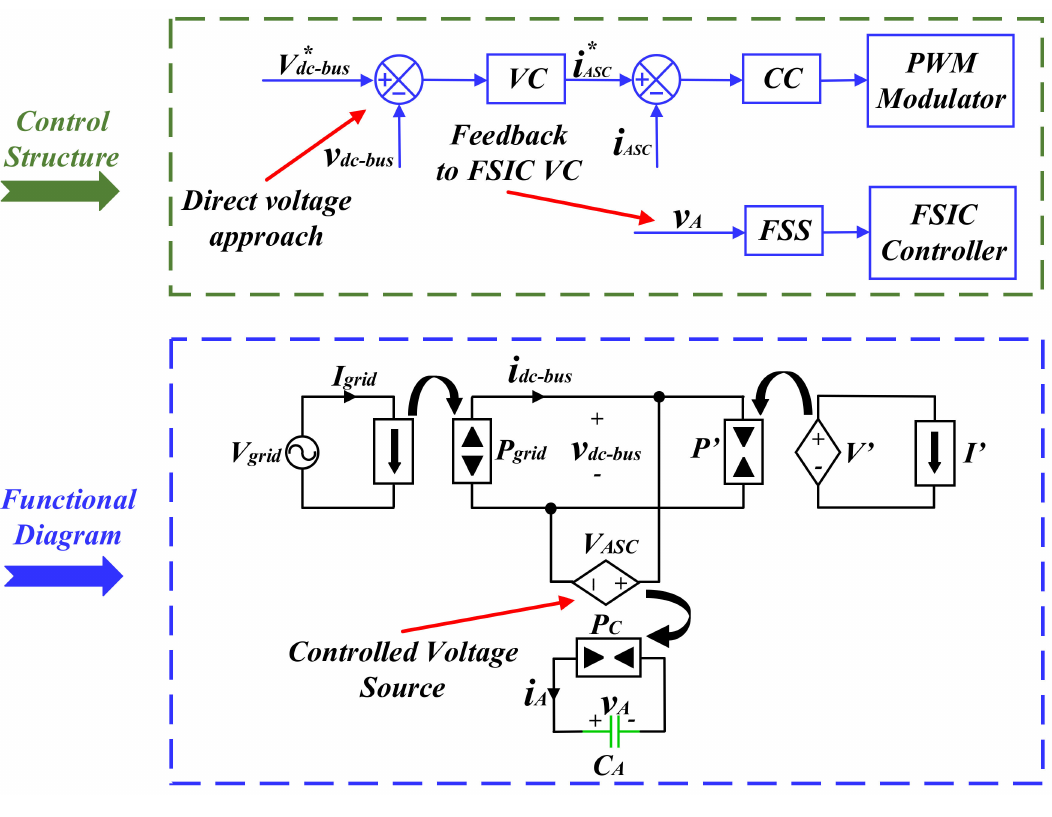
Figure 16. Controlled voltage source strategy, control structure, and functional diagram.